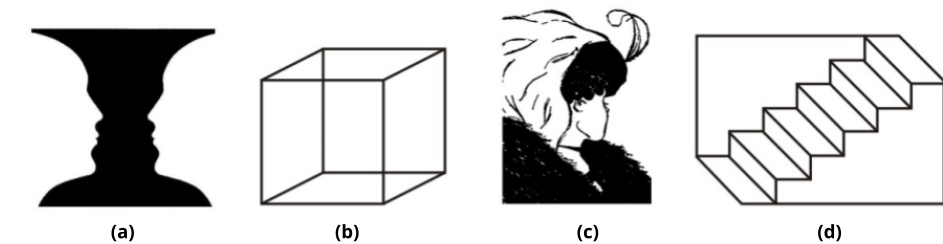
Figure 1. Examples taken from [10] of different categories of reversible (or ambiguous) figures in research on perceptual multistability: ( a ) Figure-ground reversals , Rubin ´ s vase (or vase–face illusion); ( b ) perspective reversals , Necker’s cube; ( c ) meaning-content reversals , Boring’s wife/mother-in-law; ( d ) another example of perspective reversals , Schröder’s reversible staircase.